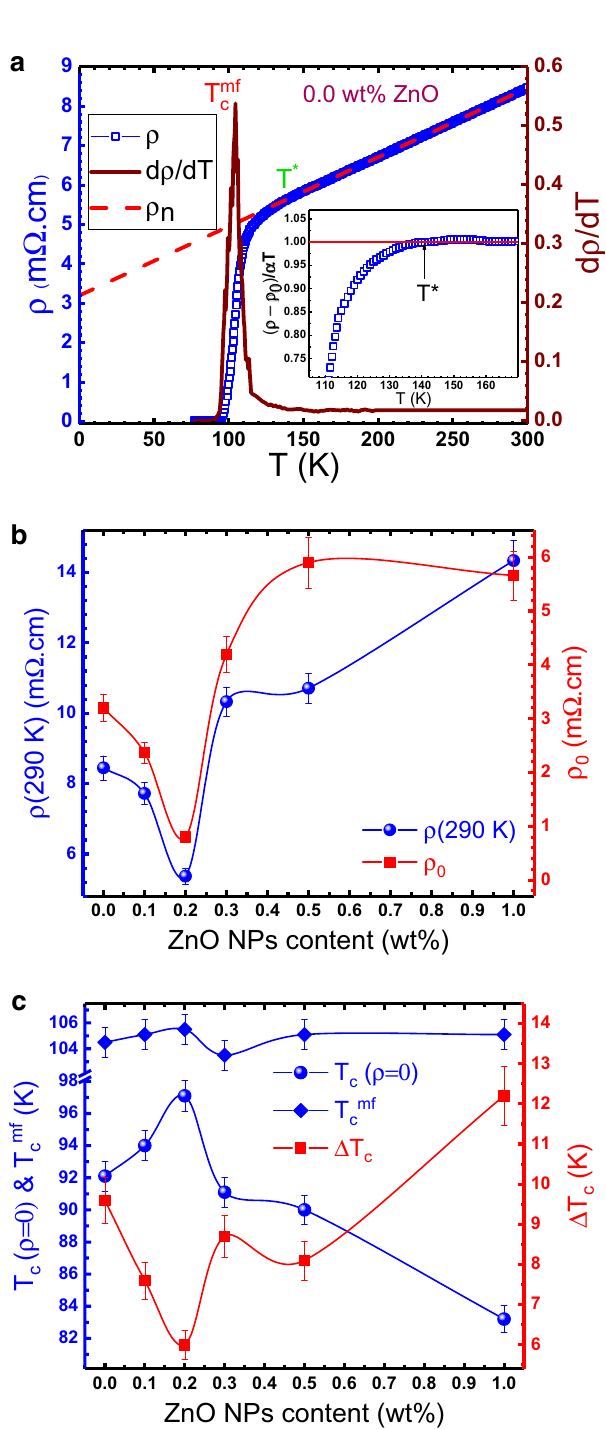
Figure 3. ( a ) Plots of the temperature dependence of electrical resistivity ρ(T), it’s corresponding derivative dρ/dT, and extrapolated normal state resistivity ρ n (T) to 0 K, for the sample with x = 0.0 wt%. The inset graph displays a more accurate determination of T* using the criterion (ρ(T)-ρ 0 )/αT = 1. ( b ) Variations of the room temperature resistivity ρ(290 K) and extrapolated zero temperature resistivity ρ 0 as a function of the ZnO NPs content. ( c ) The mean-field transition temperature T cmf , zero resistance transition temperature T c (ρ = 0), and transition temperature width ΔT c as a function of the ZnO NPs